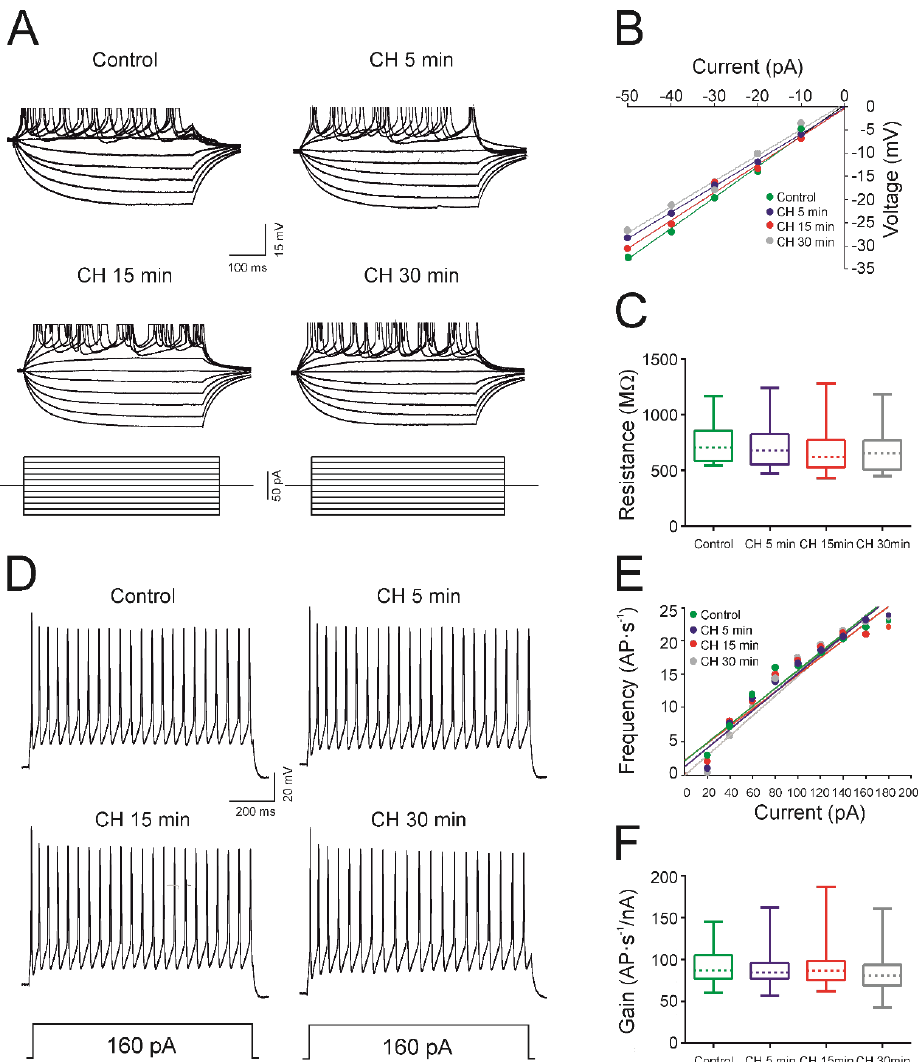
Figure 1. Effects of cumene hydroperoxide (CH) on the input resistance and firing properties in newborn rats. ( A ) Membrane voltage responses to depolarizing and hyperpolarizing current pulses in the same cell for control conditions and 5, 15, and 30 min after CH administration (10 µ M). ( B ) Relationship between values of current and voltage represented in ( A ). ( C ) E ff ect of the CH on the membrane input resistance represented as a box and whisker plot showing the medians (dashed lines), interquartile ranges (boxes), and minimum/maximum values (whiskers) for respective datasets ( n = 15). ( D ) Membrane potential responses to long-lasting depolarizing current pulses in the control situation and 5, 15, and 30 min after CH exposition. ( E ) Relationship between the current intensity and frequency of action potentials (AP) represented in ( D ). ( F ) E ff ect of the CH on the gain represented as a box-and-whisker plot showing the medians (dashed lines), interquartile ranges (boxes), and minimum / maximum values (whiskers) for respective datasets ( n = 15). All recorded neurons were able to discharge repetitively in response to a depolarizing pulse of 1 s after CH application and no changes were observed in any of the electrophysiological